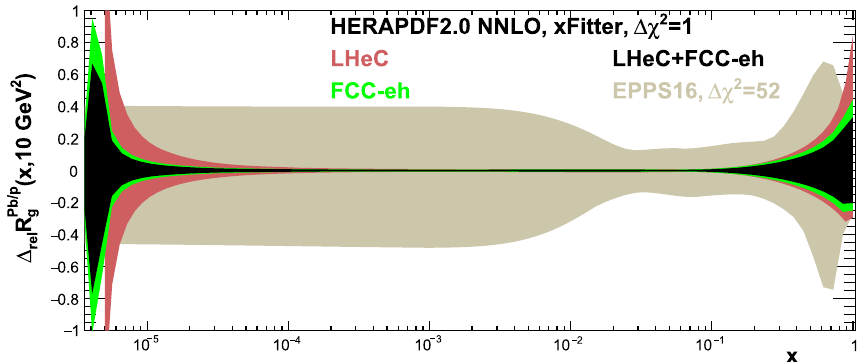
Fig. 16.10 Uncertainty in the determination of the ratio of the gluon distribution in a Pb nucleus over that in a proton, at the FCC-eh, the LHeC and its combination. Also show is the result of a recent analysis [442]. Note that while at the FCC-eh a tolerance criterium (cid:4)χ 2 = 1 can be used, it being a single experiment, present analyses use a much larger Fig. 16.11 Reduced cross sections for inclusive diffraction in ePb in different kinematic regions that could be measured at the FCC-eh (see Sect. 5.3.2), ξ being the fraction of the nucleon momentum taken by the diffractive system and β the fraction of momentum of the diffractive system taken by the parton struck. Red and green points correspond to two different models for the nuclear effects on DPDFs